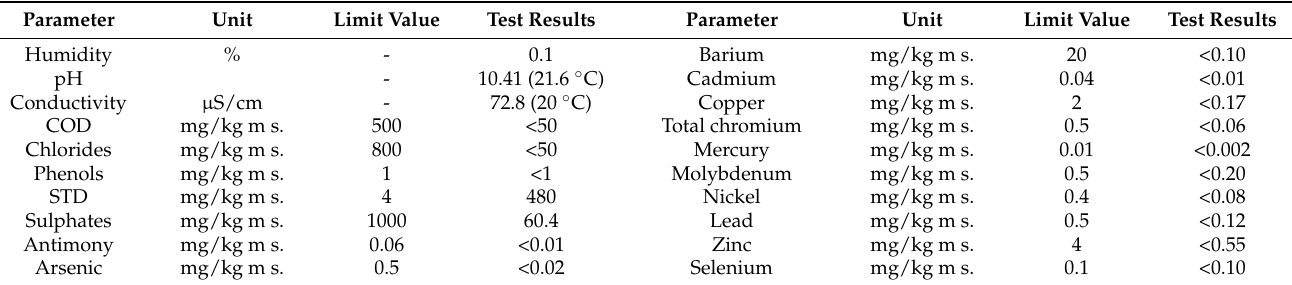
Table 5. Leachate test results.